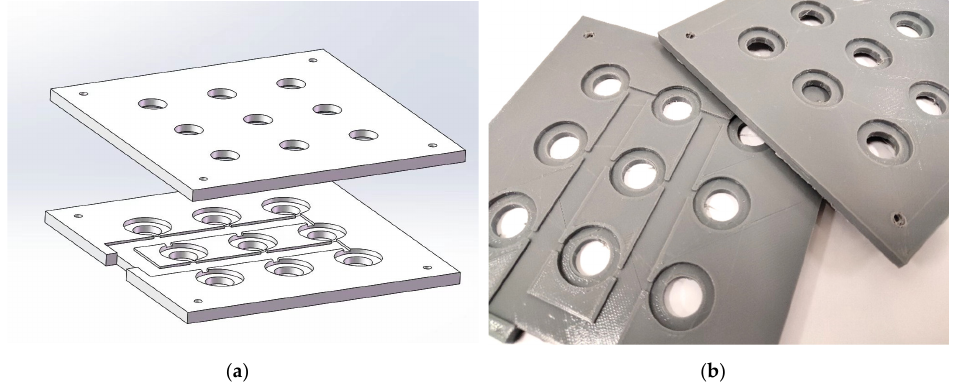
Figure 7. Mounting panels: ( a ) 3D design sketch; ( b ) printed